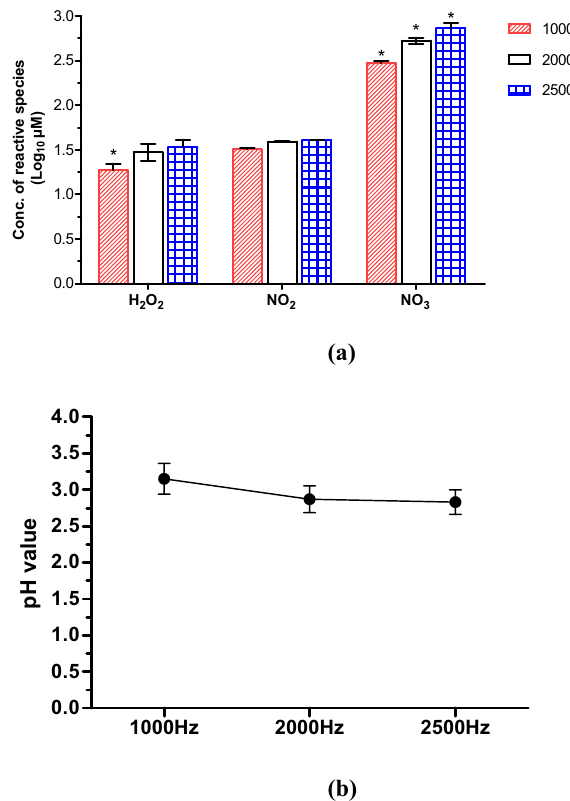
Figure 1. ( a ) Concentration of reactive oxygen/nitrogen species (RONS) and ( b ) pH values measured in water treated with a plasma pin-reactor at different system frequencies for a treatment time of 5 min. Error bars indicate standard deviation. Data were collected from two independent experiments, each one performed in duplicate (n = 4). Asterisk (*) represents significant difference (p ≤ 0.05) between different plasma system frequencies for each reactive species (H 2 O 2 or NO 2 or NO 3 ). Graphs were generated using GraphPad Prism version 5.0 (GraphPad Software, San Diego, California USA, http://www.graph